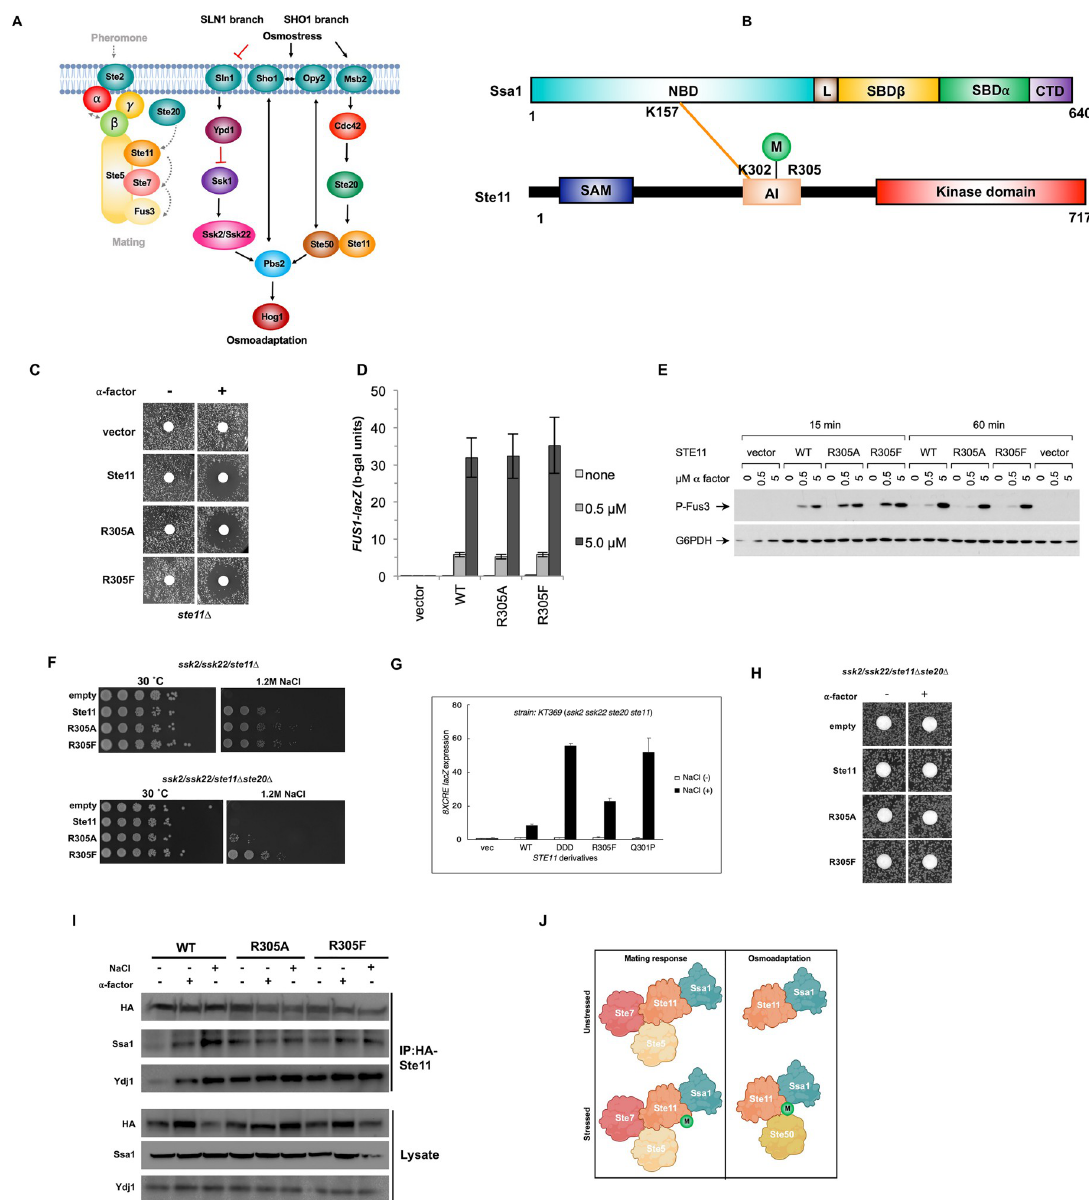
Fig 7. Ste11 dimethylation impacts the osmotic stress response. (A) Depiction of Ste11 pathway. (B) Schematic representation of Ssa1-Ste11 inter protein cross-links detected on NBD of Ssa1 and regulatory domain of Ste11. (C) Halo assay analyzing the phenotype of the Ste11 wild-type and methylation mutants in response to alpha factor. (D) FUS1-lacZ activity of Ste11 mutants in response to pheromone. Indicated yeast were grown to mid-log phase and then were processed as in [52]. (E) Western blot analysis of the effect of Ste11 wild type and mutants in response to pheromone signaling. Indicated cells were grown to mid-log phase, treated with the indicated quantity of alpha factor. Phosphorylation of Fus3 was measured by analysis of lysates via western blotting with indicated antisera. (F) Growth assay of Ste11 methylation mutants in response to hyperosmotic stress. Cells were grown to mid-log phase, were 10-fold serially diluted and then plated onto appropriate media using a 48-pin replica-plating tool. Images of plates were taken after 3 days at 30˚C. (G) 8xCRE-lacZ activity of Ste11 mutants in response to osmotic stress. Yeast transformed with the 8xCRE lacZ reporter were grown to mid-log phase and then treated with the indicated stressors. Cell lysate was extracted and beta-galactosidase activity was measured as in [50]. Data shown are the mean and standard deviation of at least 5 biological replicates. (H) Halo assay showing that none of the Ste11 variants permit pheromone response in the absence of Ste20. (I) Impact of Ste11 methylation on chaperone interactions. Yeast transformed with indicated HA-Ste11 constructs were grown to mid-log phase and Ste11 complexes were isolated using HA-magnetic beads. The purified Ste11 complexes were analyzed by SDS-PAGE/western blot analysis using indicated antisera. (J) Model of methylation-dependent regulation of Ste11 activity regulation. Di-methylation of Ste11 selectively alters osmotic signaling but not mating pathway activity. R405 di-methylation may alter Ste11 association with key osmotic signaling proteins such as Ste50. Created